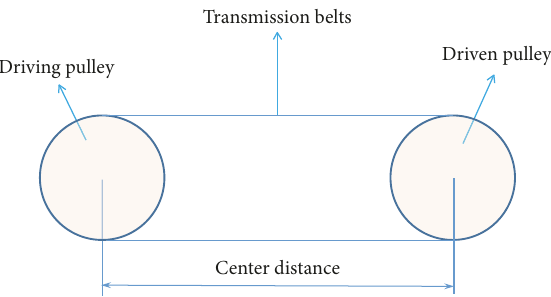
Figure 1: Structure of belt drive